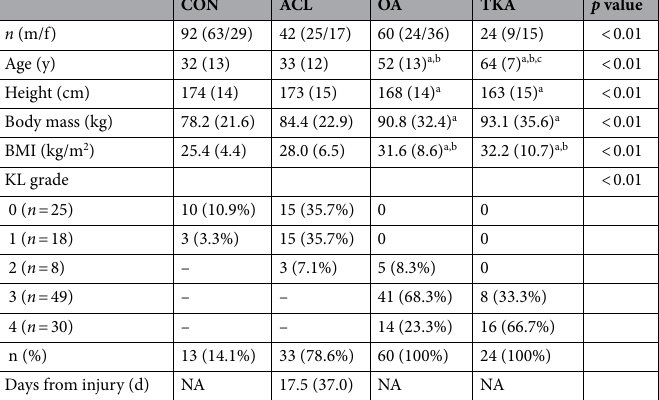
Table 1. Subject characteristics. Data presented as median (interquartile range). a p < 0.05 versus CON; b p < 0.05 versus ACL; c p < 0.05 versus OA. NA not applicable; – not